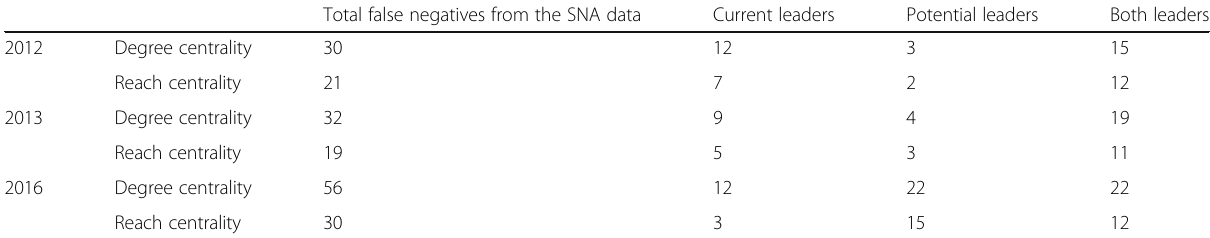
Table 7 False negatives broken down by leadership category Total false negatives from the SNA data Current